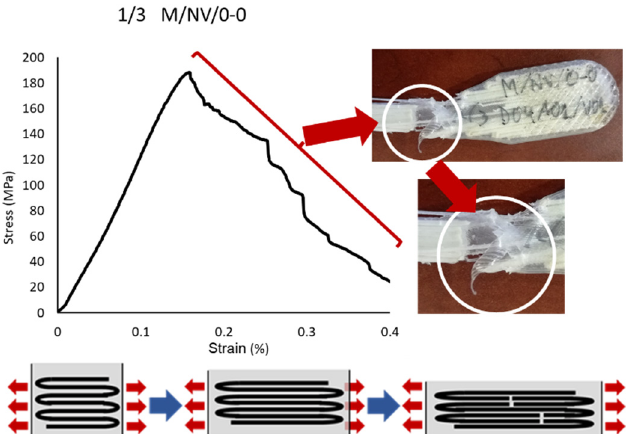
Figure 17. Breakage detail of M/NV/45-90 specimen, stress-strain graph and drawing “X” behavior scheme of the fiber.